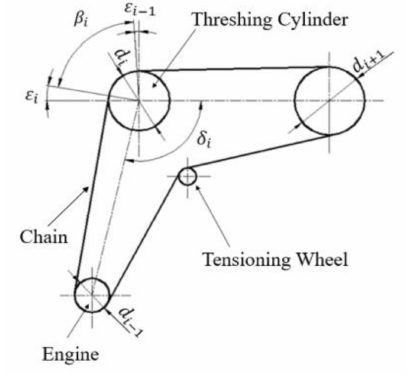
Figure 2. Double threshing drum chain drive structure and model.